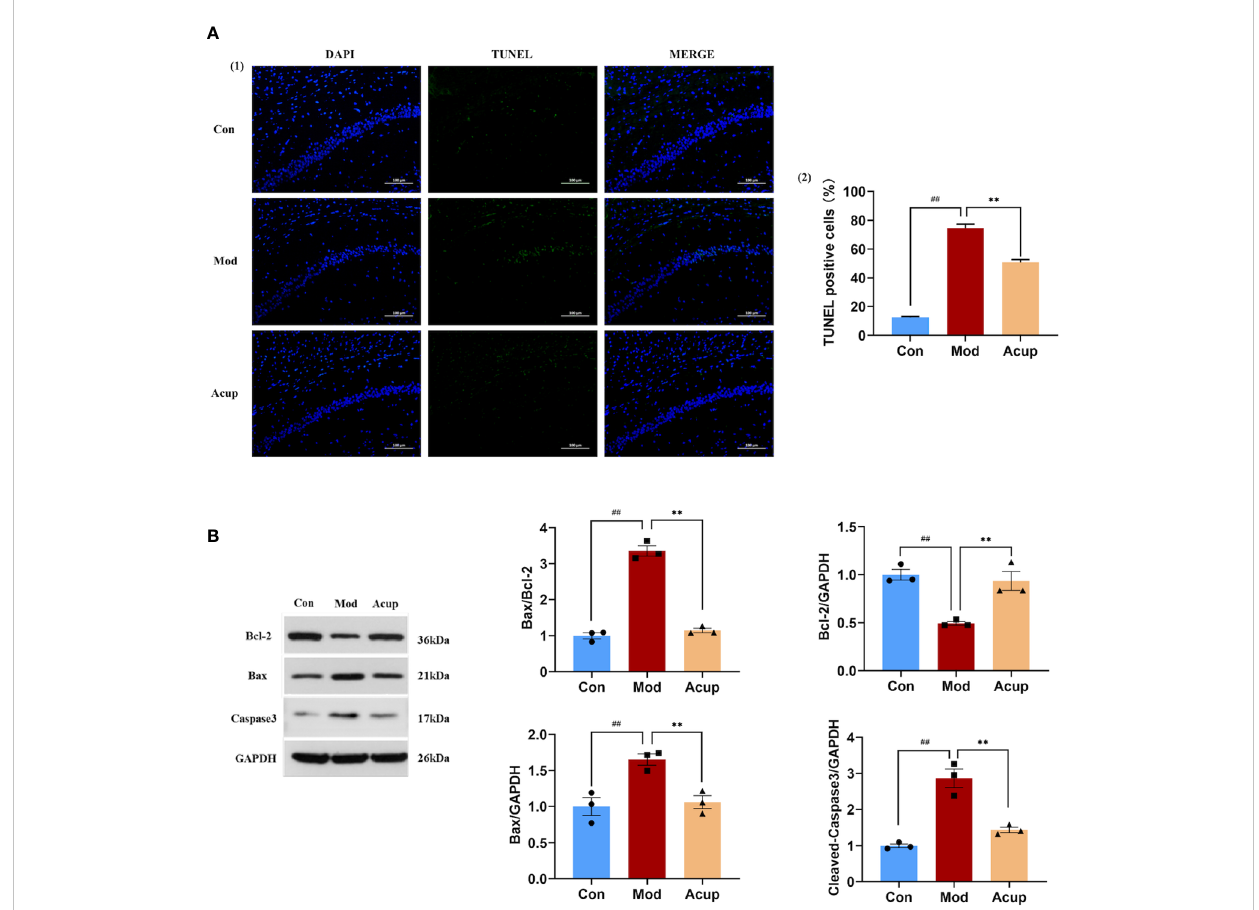
FIGURE 4 Electroacupuncture regulates db/db mice ’ s neuronal apoptosis in the hippocampus. (A) (1) The representative image of TUNEL assay showing apoptotic cells (green signal) in the CA1 regionof the db/db mice ’ s hippocampus. (2) The proportion of apoptotic neurons in the CA1 region of the hippocampus in three groups. (B) Western blotting and quantitative analysis of Bax, Bcl-2, and caspase-3 expression in the hippocampus of mice in three groups. Data are expressed as means ± SEM. Mod vs Con, ## p < 0.01; Acup vs Mod, ** p <